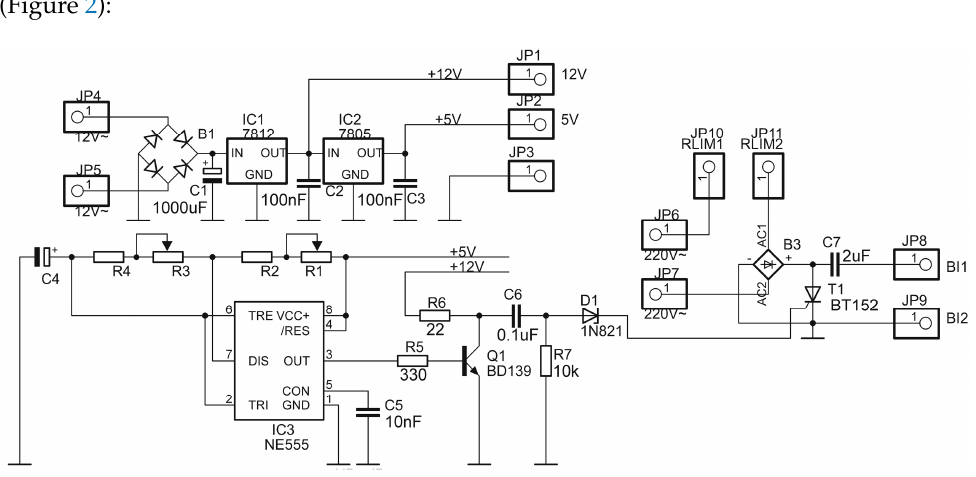
Figure 2. The electronic schematic of our plasma generator